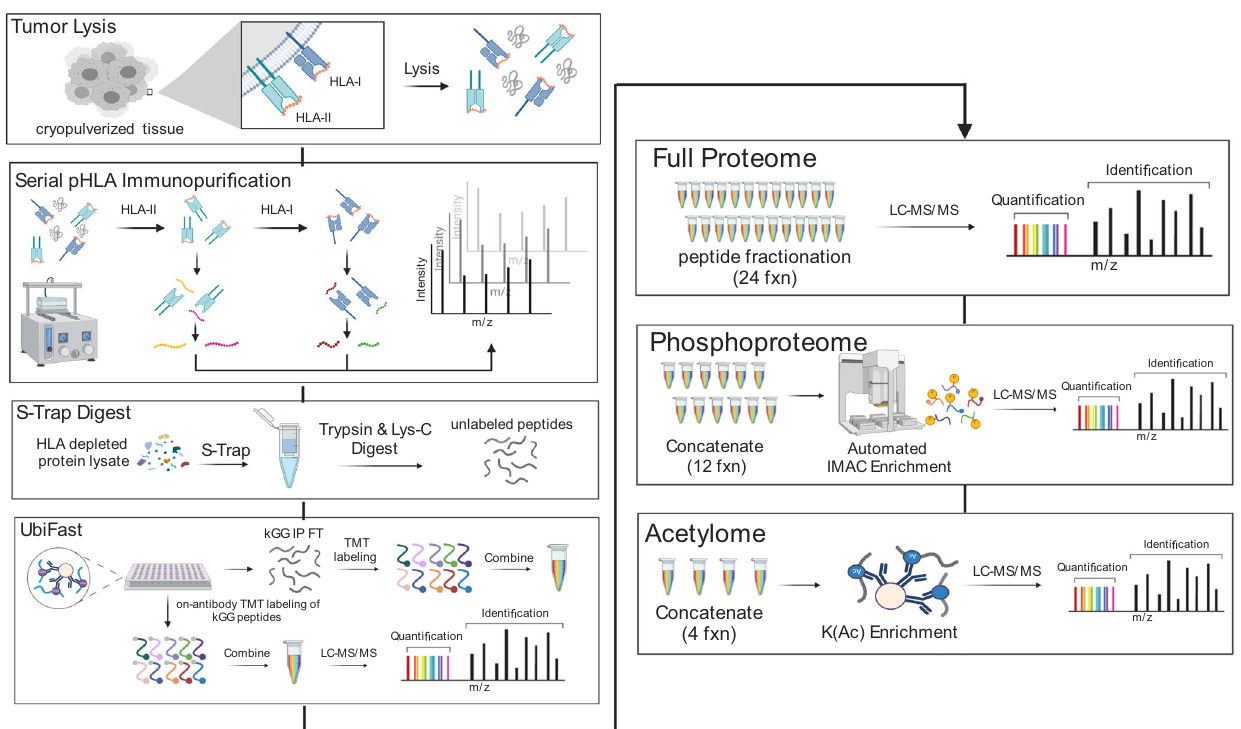
Fig. 1 | Schematic Overview of the MONTE work fl ow. The Multi-Omic Native Tissue Enrichments (MONTE) work fl ow for serial HLA immunopeptidome (label- free), ubiquitylome (label-free enrichment and on-antibody TMT labeling),